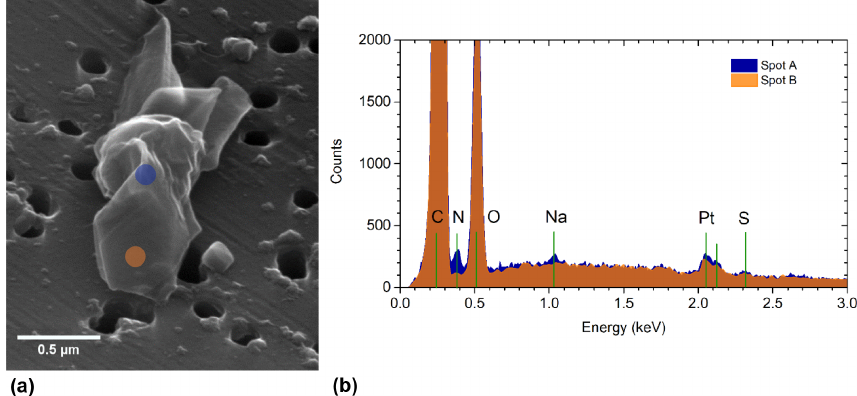
Figure 10. Same as Fig. 4 but for a biological particle. EDX spectra were obtained from different areas on the particle (marked as colour spots in the image). A clear biogenic signature (N, S, Na) is visible for the central bulky part, suggesting intracellular composition (spot A, blue colour), whereas the exterior part of the particle shows pure carbonaceous compounds (C, O) (spot B, orange colour). Sample coating is responsible for the platinum peak.